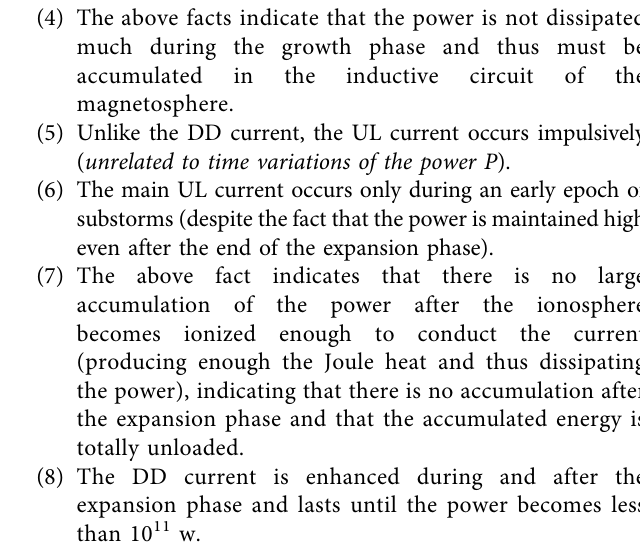
the power is manifested by an increase of the current across the magnetosphere or the resulting changes of the magnetic fi eld con fi guration at about the distance of 6 Re for medium intensity substorms, Figure 11B .